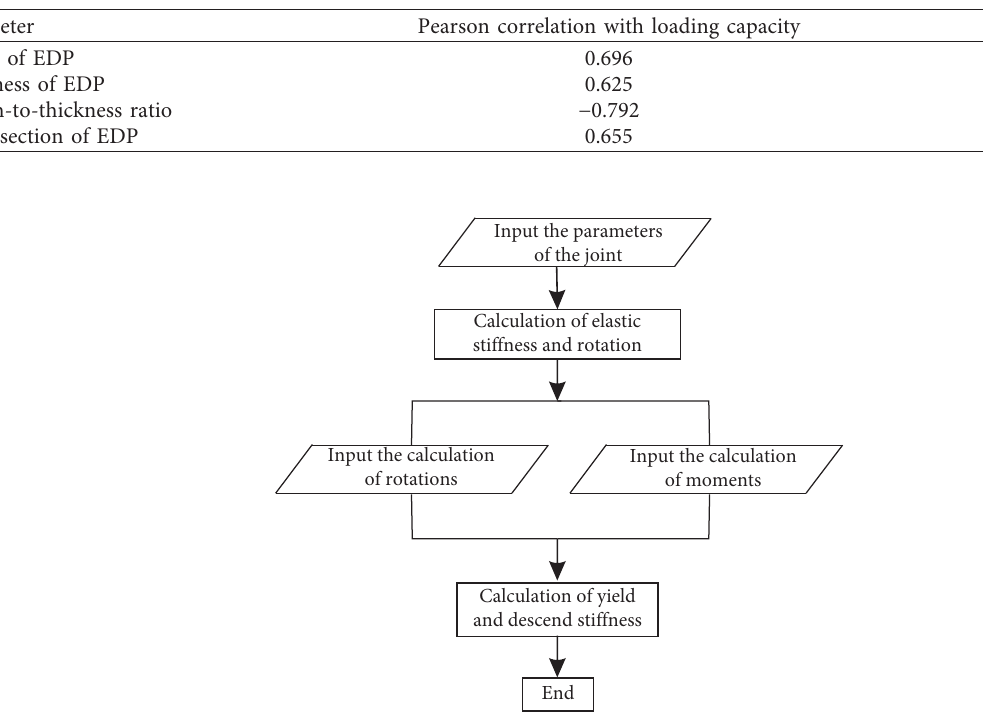
Figure 9: FE simulation results in ABAQUS: (a) stress nephogram of EDP; (b) failure mode; (c) displacement-force curve. Table 8: The Pearson correlation and reliability of different parameters.